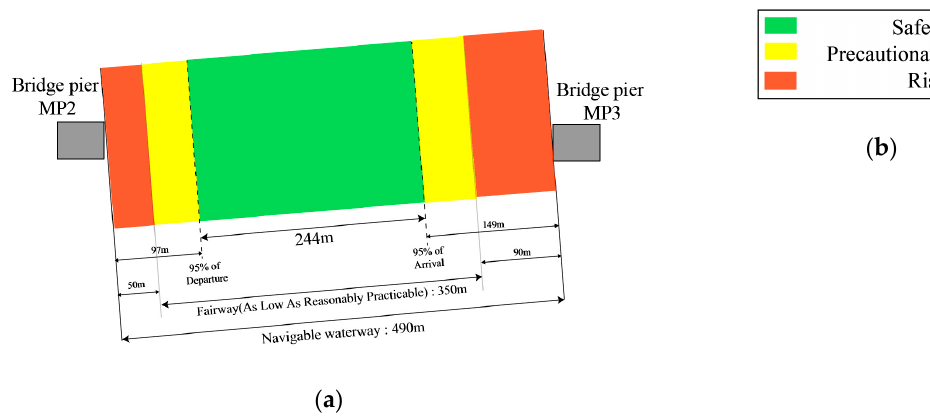
Figure 17. Ship safety distance for 2-way traffic situation at the ( a ) Incheon bridge and ( b ) legend. For the Busan harbor bridge, the Safety zone according to traffic distribution corresponding to the 95% confidence interval is 244 m, and it is within the 49.8% range based on the navigable waterway (490 m). The Precautionary zone is in the 21.6% range based on the navigable waterway, whereas the Risk zone is within the 28.6% range (Figure 18).